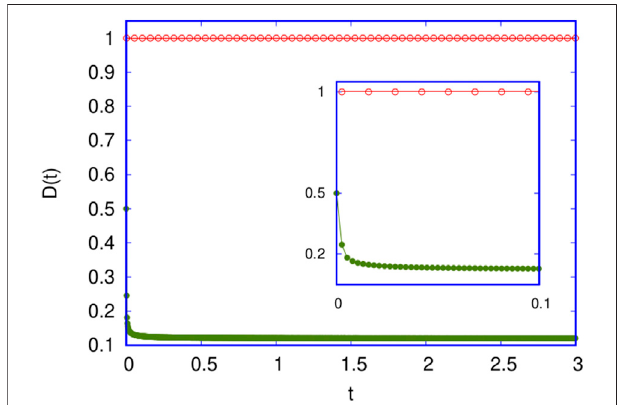
FIGURE 1 | Noise intensity as a function of time for the 2+1 SS model. The upper curve corresponds totheapplied noisewhile thelower curve tothe effective noise, i.e., the noise that actually propagates through the lattice after being fi ltered by the rules of the SS model. The inset shows the short- time